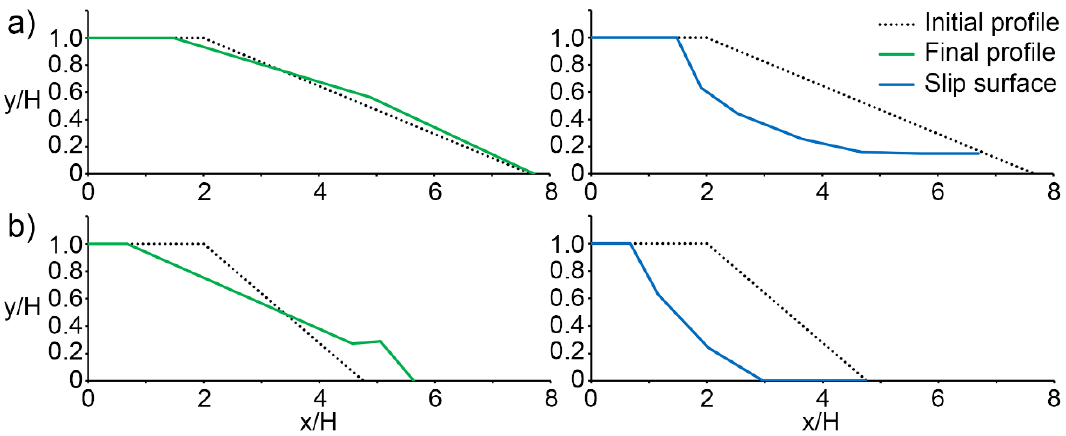
Figure 11. Dimensionless post-failure profile and slip surface location for the case with H = 5 m, φ’ = 35°, Δu = 40 kPa, α = 10° ( a ), and α = 20° ( b ).